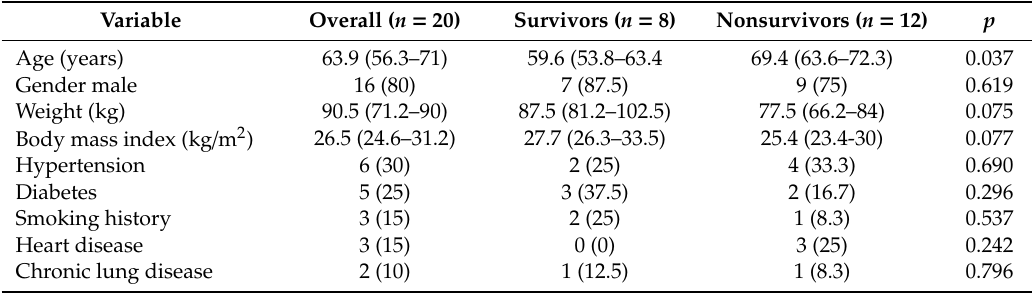
Table 1. General profile of the patient population at the admission to the intensive care unit and